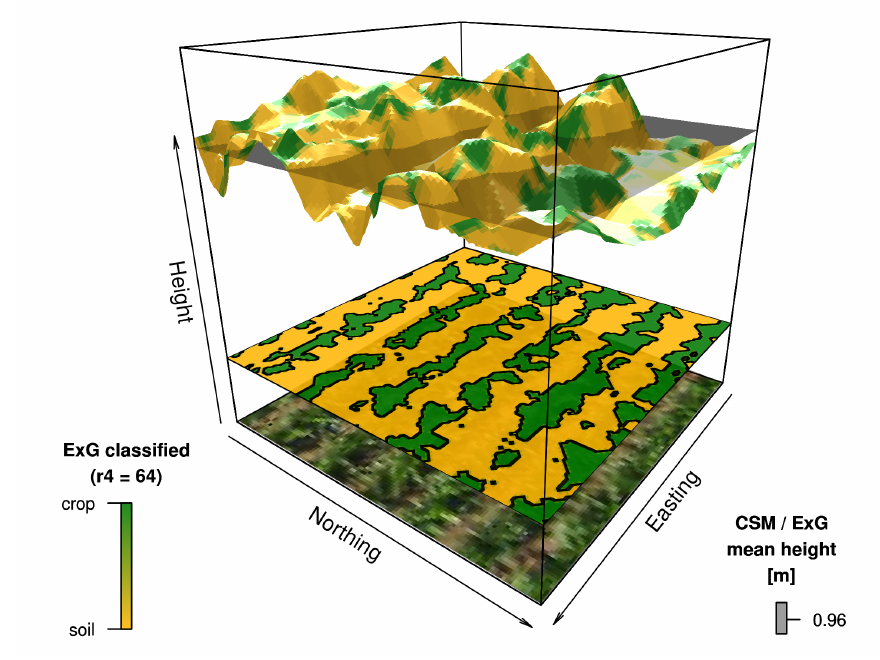
Figure 4. Mean crop height computation using the example of a 4 × 4 m sub-sample of plot 413 with a sowing density of 11 seeds · m − 2 and nitrogen application of 50 kg · N · ha − 1 . The lower part of the figure shows a stack of the RGB orthoimage and the ExG layer classification based on threshold r at a ground resolution of 0.04 m and at crop growth stage Z39. The 4 upper part shows the corresponding CSM layer height information as a 3D representation, colored by the ExG-classification. Mean crop height was calculated by the crop-classified CSM layer heights only and is displayed as a semi-transparent